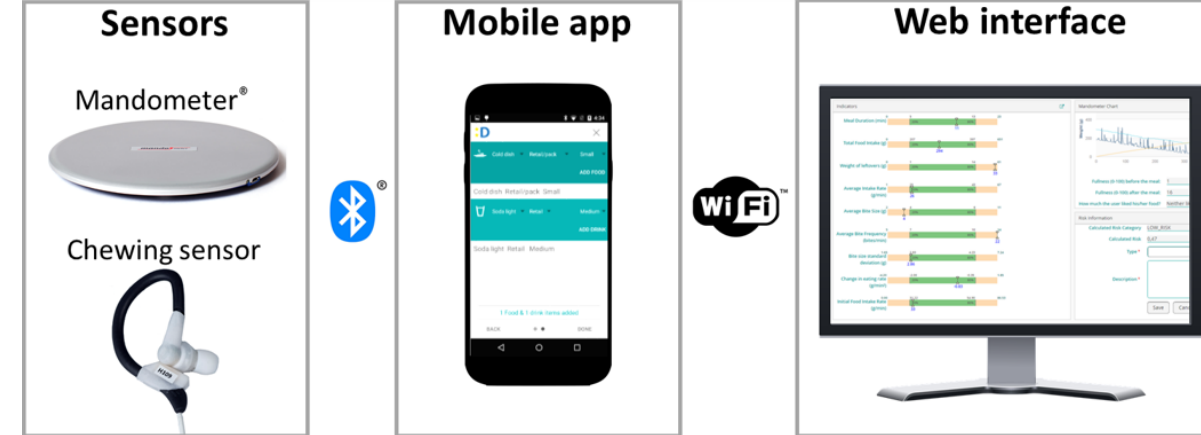
Figure 1. The system consists of a digital food scale, chewing sensor, smartphone app, and web app.